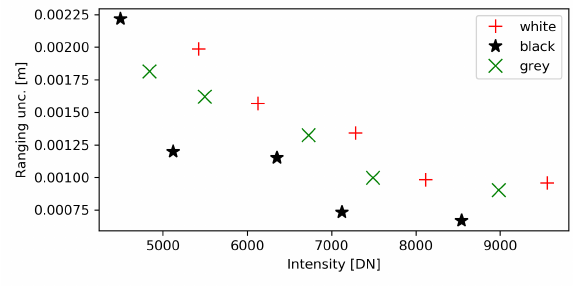
Figure 5. VZ-2000i ranging uncertainty vs. intensities for a constant incidence angle of 0 ◦